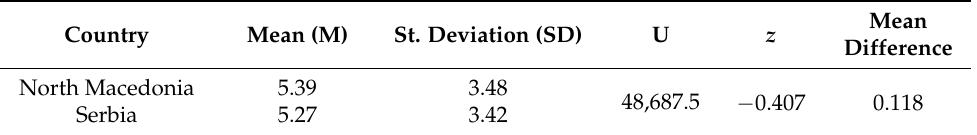
Table 3. Descriptive statistics and the Mann–Whitney U-test for Serbian and North Macedonian students’ achievement on the TUG-K test.